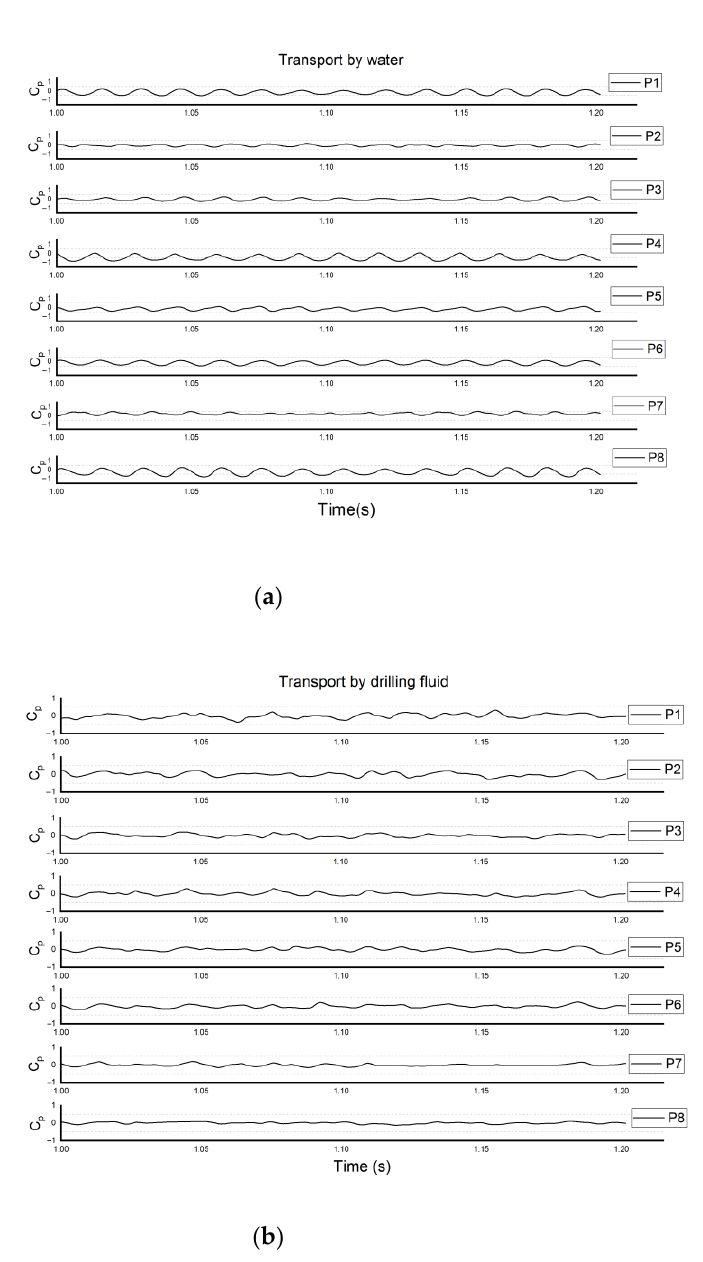
Figure 9. Pressure coefficients at the different points within volute (P1 – P8). ( a ) Water case; ( b ) drilling-fluid case.